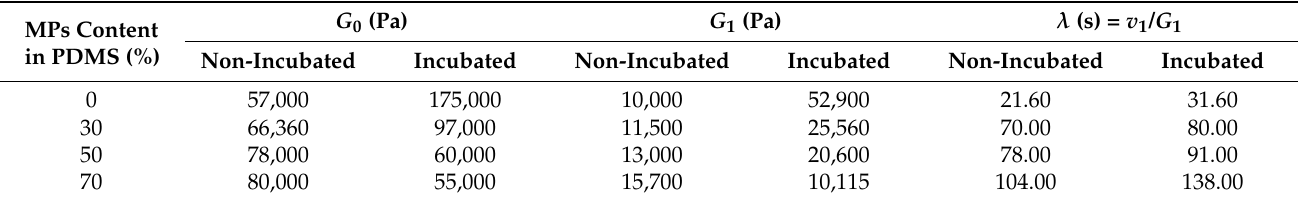
Table 6. SLSM parameters for data from the relaxation modulus and oscillatory tests with fit R 2 >